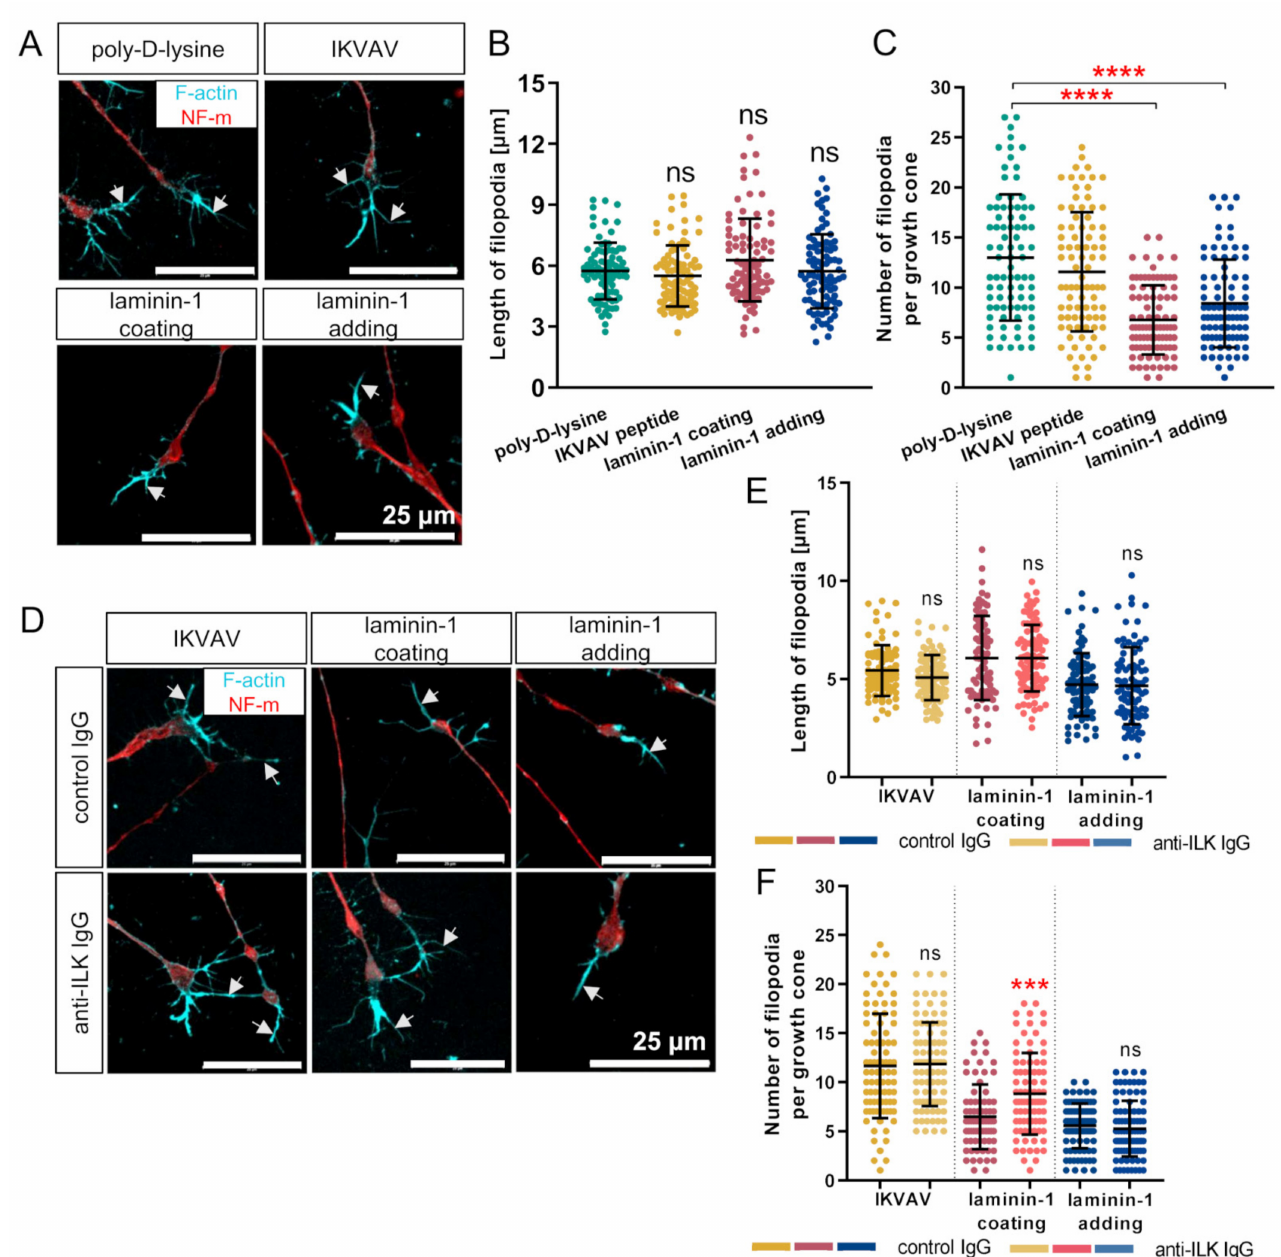
Figure 8. ILK modulates the morphology of a growth cone. DRG were cultured on a laminin-1-coated surface or with addition to the medium of IKVAV peptide or laminin-1 for 48 h. Additionally, control or anti-ILK antibodies were added to the medium. ( A , D ) DRG were then immunostained with NF-m to detect DRG neurites and stained with Alexa Fluor 568-phalloidin to label growth cones’ filopodia rich in F-actin. White arrows point at filopodia rich in F-actin. ( B ) Quantitative analysis of the length of filopodia of DRG growth cones; ns—not significant; ( n = 90). ( C ) Quantitative analysis of the number of filopodia formed per one growth cone; p ≤ 0.0001 (****); ( n = 90). ( E ) Quantification of the length of growth cone filopodia of DRG grown with the addition of anti-ILK antibodies; p ≤ 0.001 (***); ns—not significant; ( n = 90). ( F ) Quantitative analysis of the number of filopodia formed per one growth cone after interruption of ILK’s function; p ≤ 0.001 (***); ns—not significant; ( n = 90). All graphs show mean ± SD. The morphology of ten growth cones per DRG was